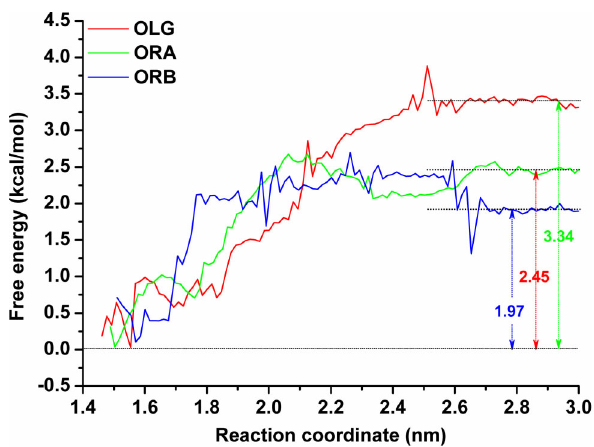
Figure 8. Free energy profiles determined for OLG, ORA and ORB binding with a -HL. The reaction coordinate was defined as the distance between the center of mass of all of the atoms of OLG, ORA or ORB and the center of mass of all of the atoms that belong to a -HL.